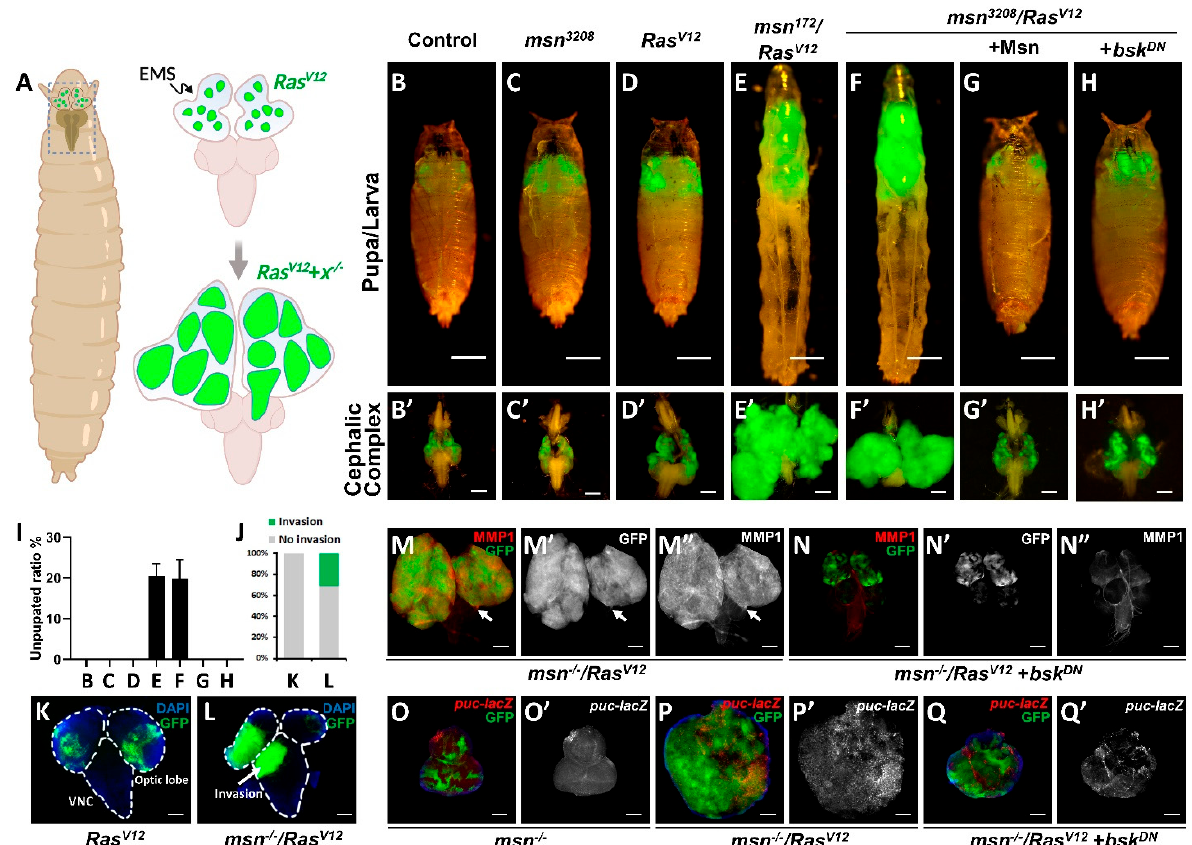
Figure 1. Loss of Misshapen ( msn ) synergizes with oncogenic Ras (RasV12) to induce tumorigenesis and invasion. ( A ) Strategy of an ethyl methanesulphonate (EMS)-induced forward genetic screen in developing Drosophila eye to identify novel Ras V12 collaborating tumor suppressors. ( B – H ) Fluorescence micrographs of GFP-labeled pupa/larva are shown in the top panels, cephalic complexes dissected from third-instar larvae are shown in the bottom. Compared with control ( B , B ’), loss of msn alone has no obvious overgrowth ( C , C ’), ectopic expression of Ras V12 alone only induces mild tumor growth ( D , D ’). msn − / − / Ras V12 tumors display significant overgrowth ( E , F and E ’, F ’), which can be rescued by co-expression of Msn ( G , G ’) or co-expression of a dominant negative form of basket ( H , H ’). ( I ) Quantification of unpupated ratio for indicated genotypes in B – H . ( J – L ) Fluorescence micrographs of GFP-labeled Optic lope and ventral nerve cord (VNC) dissected from third-instar larvae are shown, arrow indicates invasion sites ( K , L ). ( J ) Quantification of invasion ratio in ( K ) and ( L ). ( M – Q ) Loss of msn collaborates with Ras V12 to induce tumorigenesis through activating c-Jun N-terminal kinase (JNK) signaling pathway. Expression of basket ( bsk DN ) suppressed msn − / − /Ras V12 -induced MMP1 expression, tumor invasion ( M – N ”), and upregulation of puc transcription ( O – Q ’); note that loss of msn alone does not significantly induce MMP1 activation ( O , O ’). Scale bars represent 500 μ m ( B – H ), 200 μ m ( B ’– H ’, M – M ”, and N – N ”), or 100 μ m ( K – L , O – Q , and O ’– Q ’).